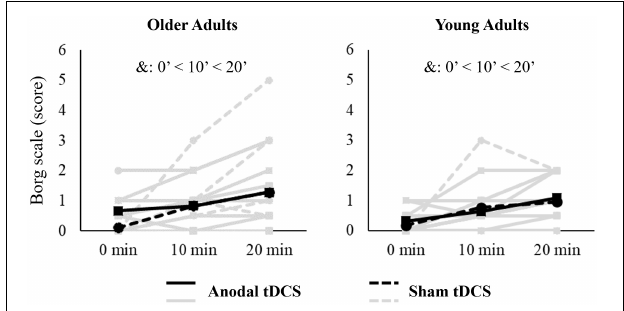
FIGURE 3 | Individuals (light gray lines) and means data (black lines) of perceived exertion scale (Borg) applied during 20-min treadmill walking combined with tDCS. &: indicates a main effect of intervention